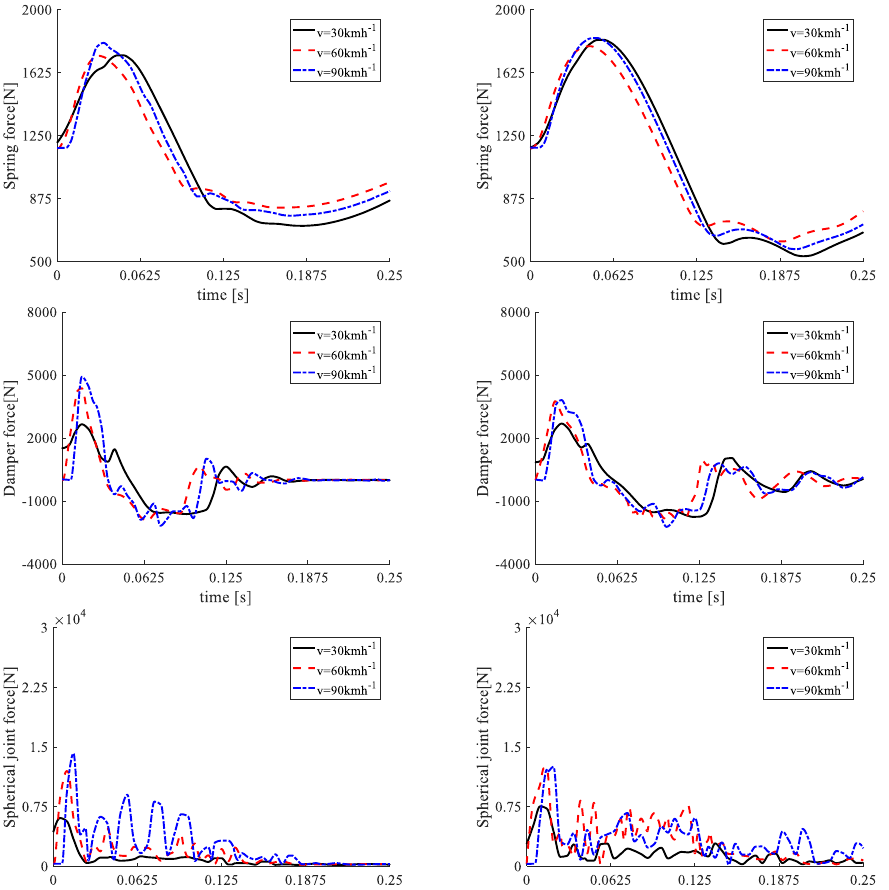
Figure 14. Selected time courses obtained for the suspension model with the flexible beam during overcoming the E-type obstacle.